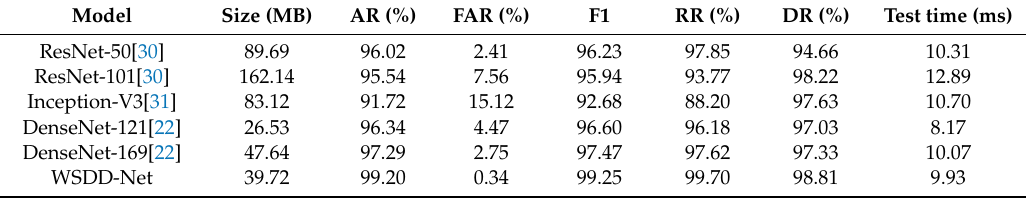
Table 1. Comparisons with classical deep convolutional neural networks (CNNs). Model